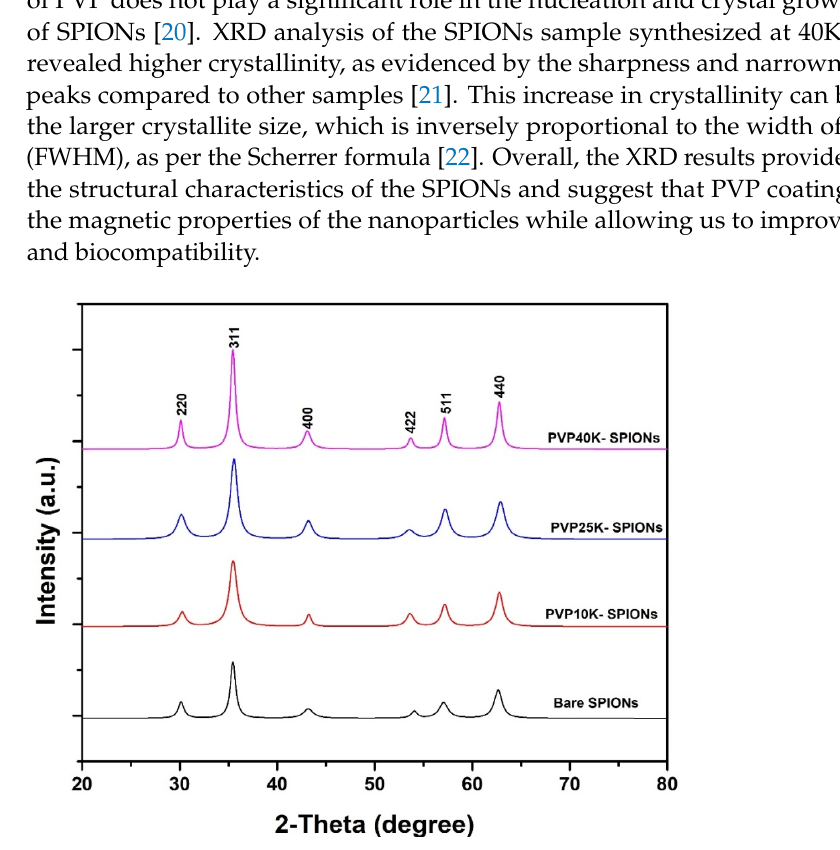
Figure 2. X-ray di ff raction (XRD) pa tt erns of bare and coated superparamagnetic iron oxide nano- Figure 2. X-ray diffraction (XRD) patterns of bare and coated superparamagnetic iron oxide nanopar- particles (SPIONs) synthesized through the one pot co-precipitation method. ticles (SPIONs) synthesized through the one pot co-precipitation